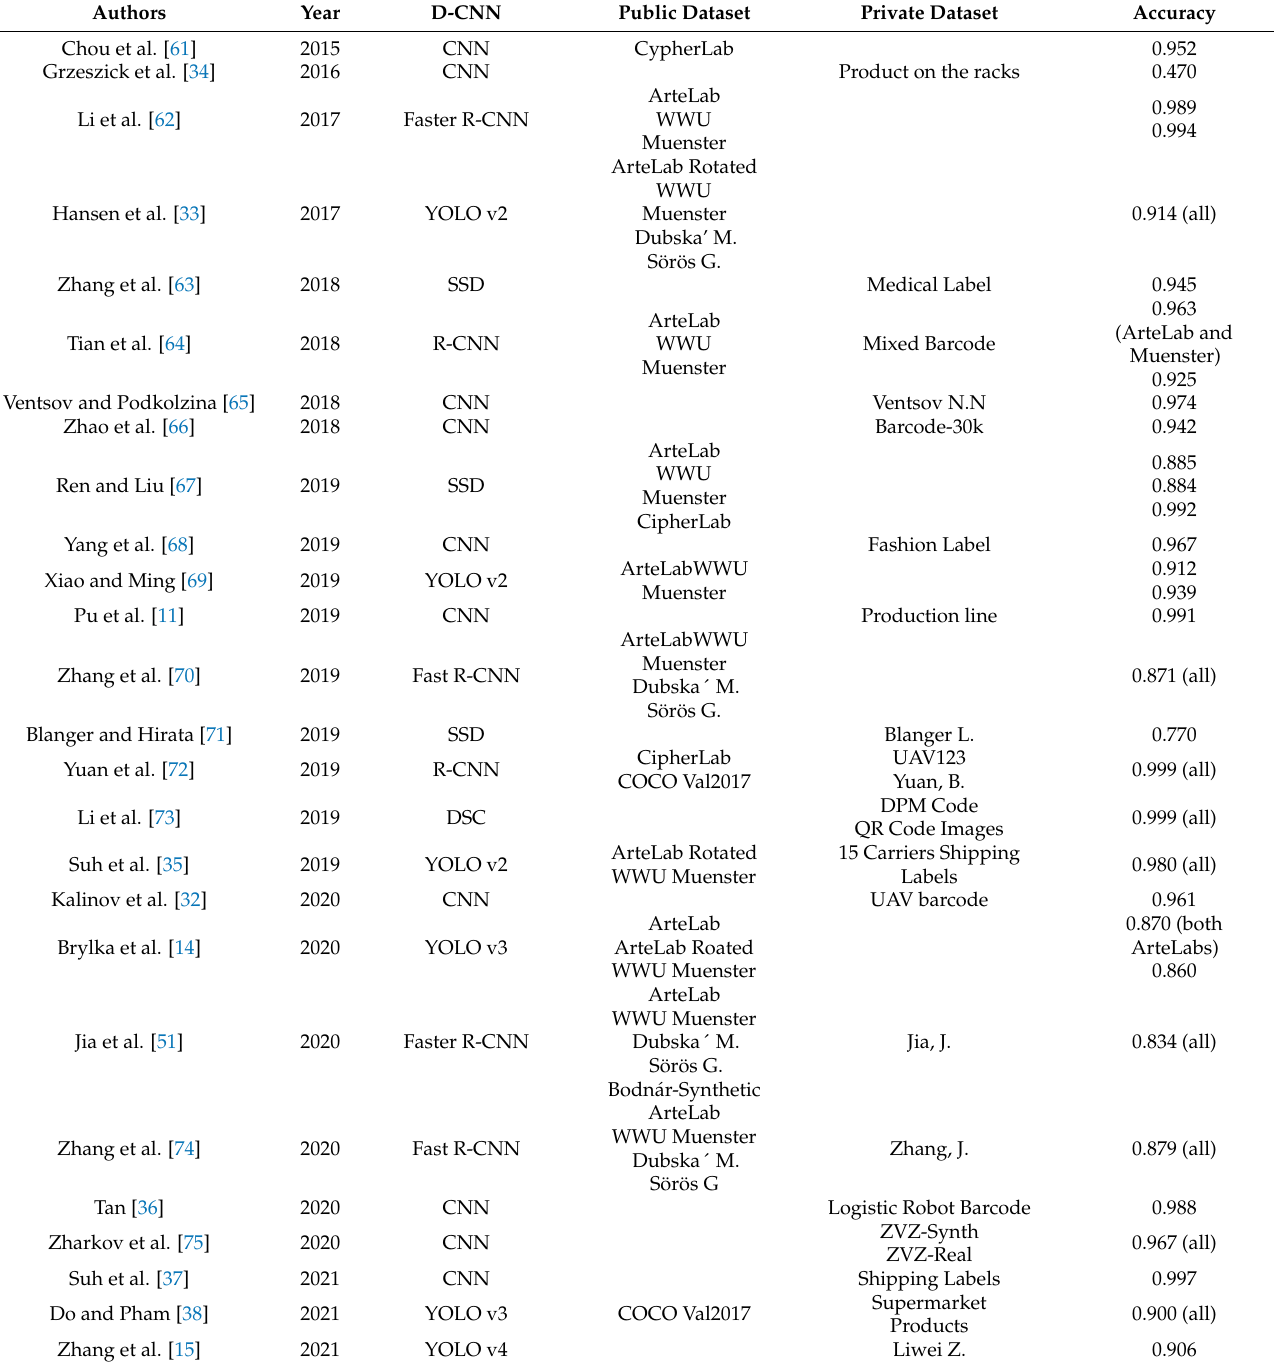
Table 2. D-CNN-based barcode recognition methods employed over